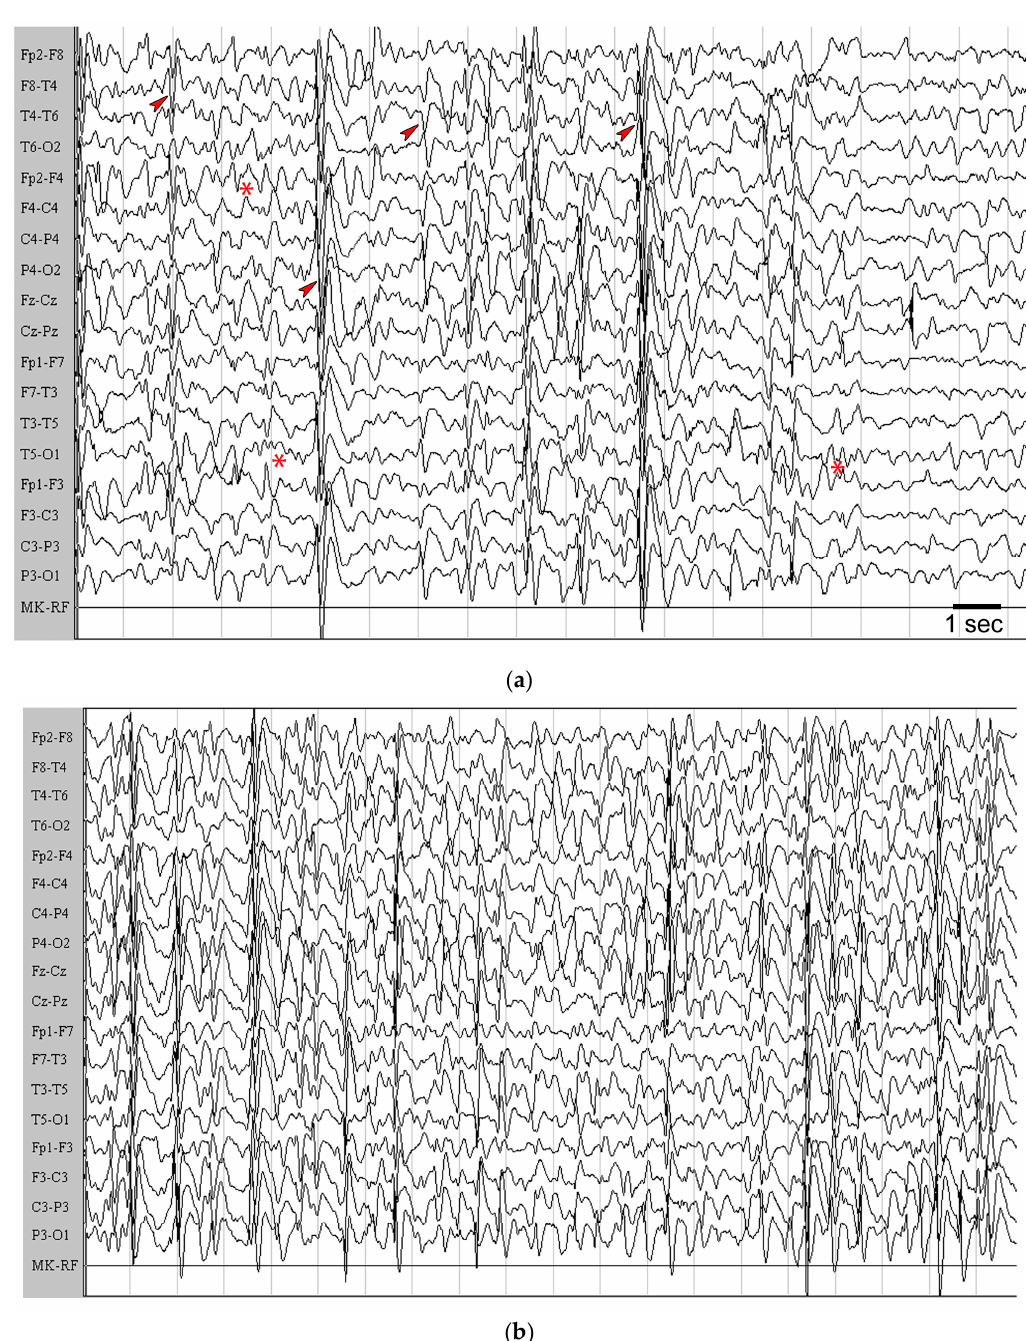
Figure 6. The awake electroencephalogram (EEG) of patient #18 is illustrated. ( a ) EEG before starting the ketogenic diet (KD). Note that a short sequence of posterior 5–6 Hz activity is detectable (asterisks). Then, this rhythm was interrupted by frequent high-voltage, generalized, and multifocal sharp-waves that tended to synchronize in short bursts (arrowheads), followed by a moderate reduction of the electrical amplitude. ( b ) Under treatment with the KD, the presence of continuous, high-amplitude, generalized sharp-waves and slow-waves starting from the frontal region is appreciable. These waves synchronized in short generalized bursts followed by mild suppression of basal activity. Note also that the physiological posterior rhythm was not present. EEG recording was made by a 12 channel system (Galileo NT Suite Software). Images are presented on longitudinal reading montages. Amplitude, 20 µV/mm.